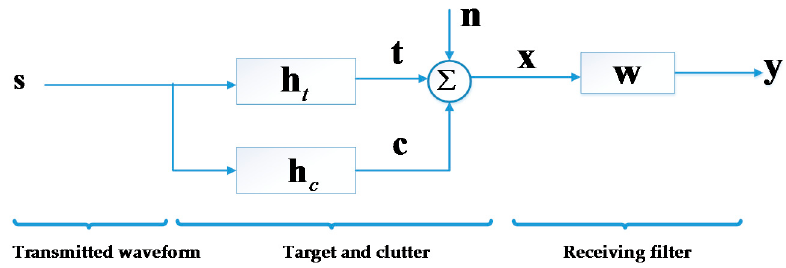
Figure 1. Illustration of the radar’s discrete baseband signal model.